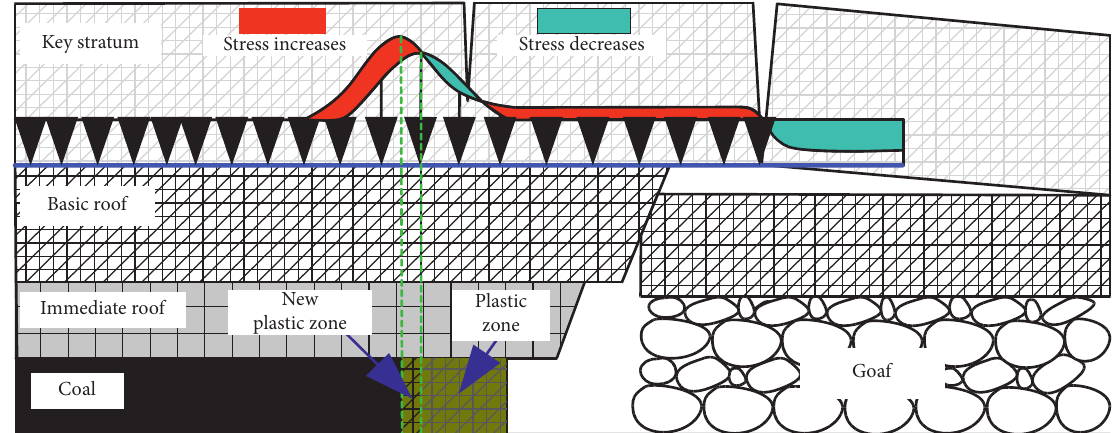
Figure 8: Stress and plastic zone change of surrounding rock under dynamic loading.